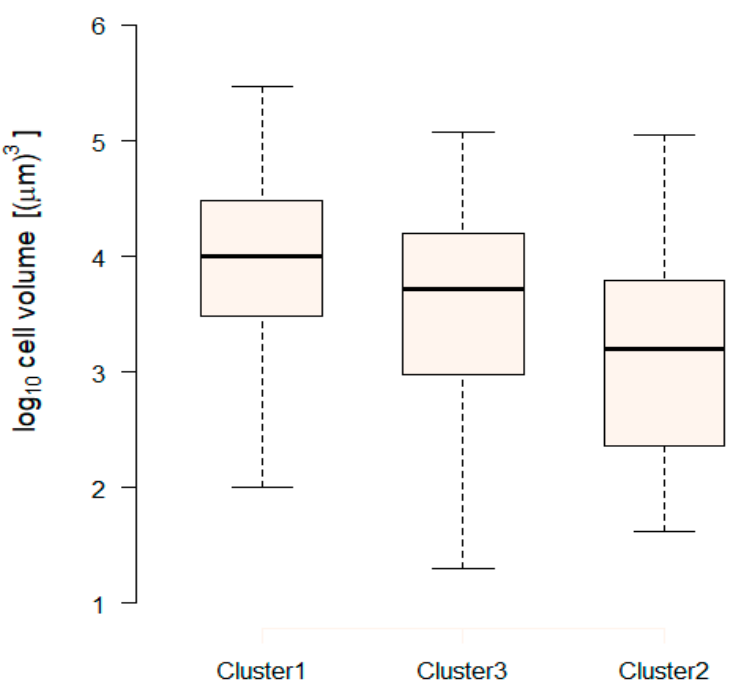
Figure 5. Box and whisker diagrams of log cell volume distributions in the three trait-based clusters based on the maximum a posteriori clustering solution. Each box plot shows the median (thick line), the interquartile range (box) and the full range of the distribution from 1.5 interquartile range below the first quartile to 1.5 interquartile range beyond the third quartile (whiskers). Clusters are arranged in order of decreasing medians.